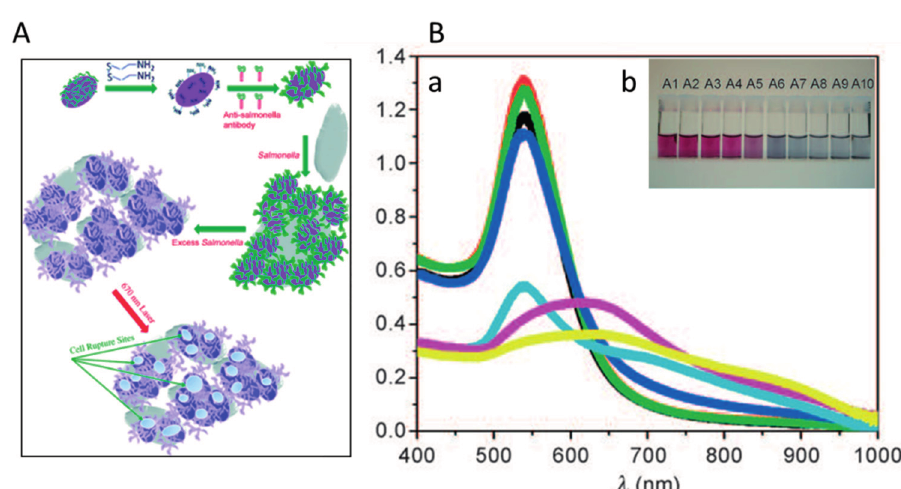
Figure 1. ( A ) Schematic of a colorimetric AuNPs based approach to selectively target and destroy pathogenic bacteria with antibody-conjugated oval-shaped AuNPs; ( B - a ) Absorption-profile of anti-salmonella-antibody-conjugated oval-shaped AuNPs in the absence of bacteria ( red ) due to the addition of 10 6 CFU/mL E. coli bacteria ( green ) or different concentrations of Salmonella bacteria (10 ( black ), 50 ( dark blue ), 10 3 ( light blue ), 10 4 ( pink ), and 10 5 bacteria ( yellow )). The new band at around 680 nm following the addition of Salmonella , indicates the aggregation of the AuNPs ( B - b ) Photograph shows colorimetric change upon the addition of (A1) 10, (A2) 50, (A3) 100, (A4) 500, (A5) 1000, (A6) 5000, (A7) 10,000, (A8) 50,000, (A9) 100,000, and (A10) 500,000 Salmonella (reprinted with permission from [41]).